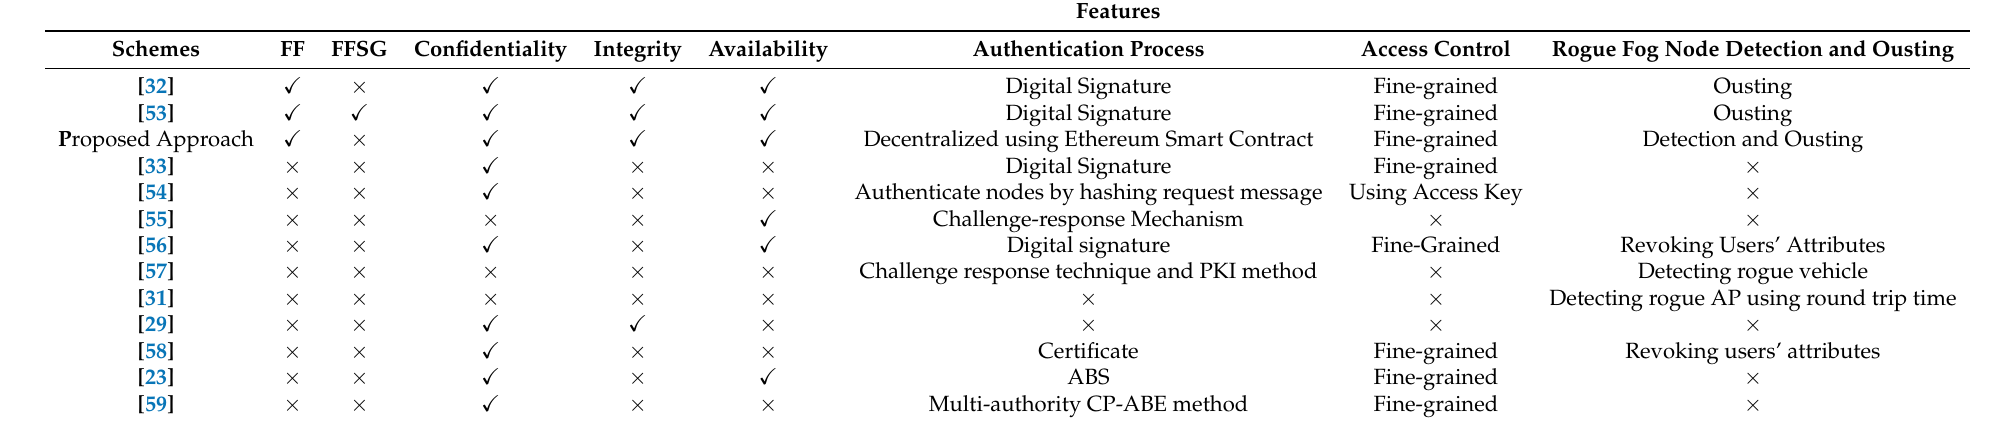
Table 5. Comparison between our approach and approaches from